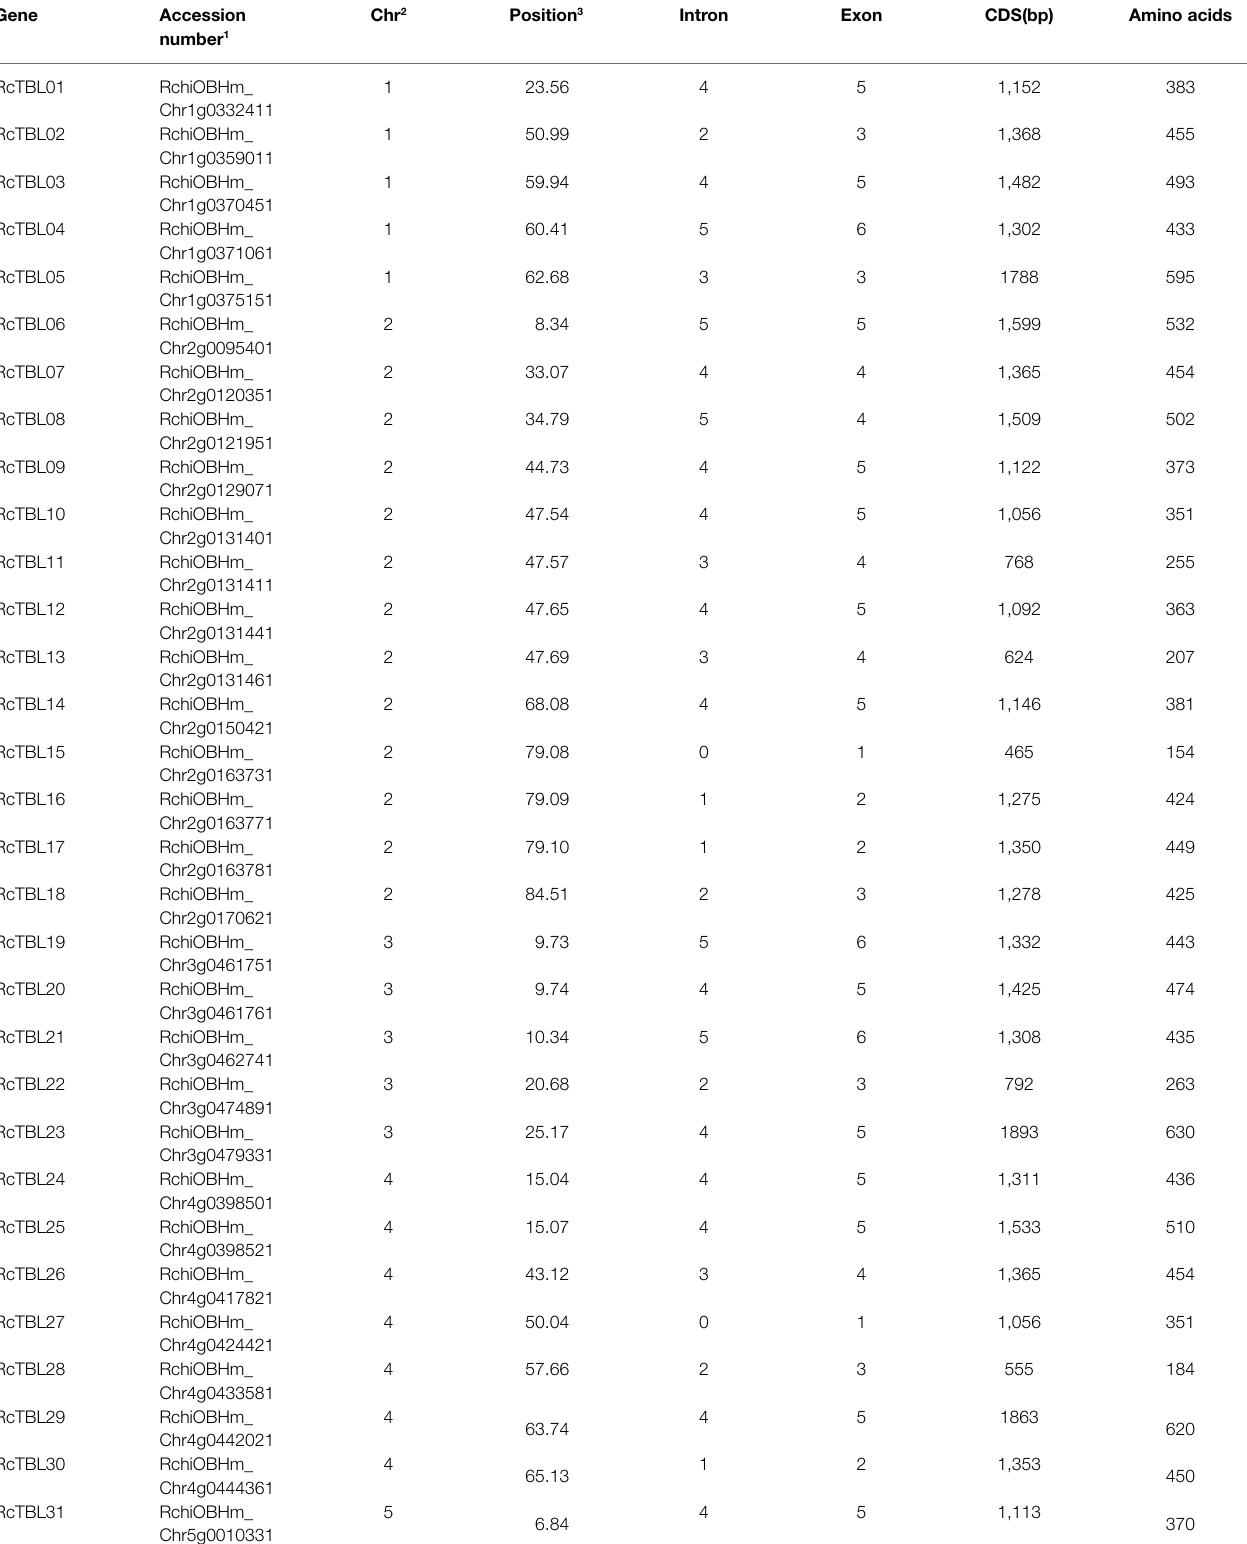
TABLE 1 | Members of the RcTBL gene family as predicted in Rosa chinensis genome